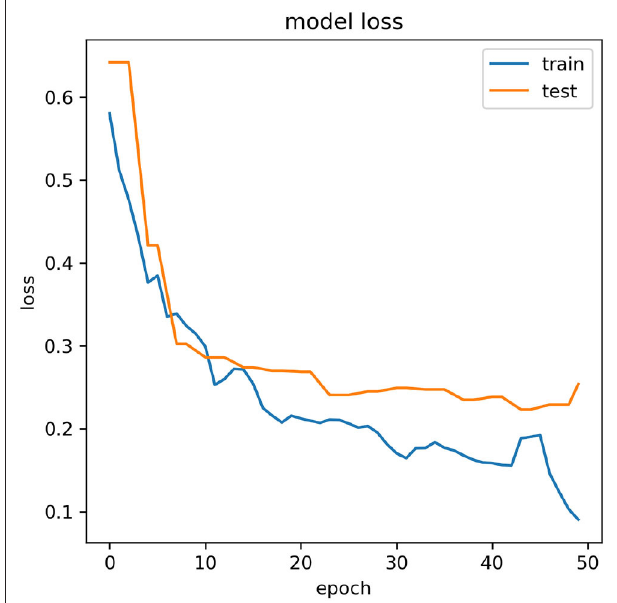
FIGURE 5 | Variation of model loss with the number of epochs for participant 4.